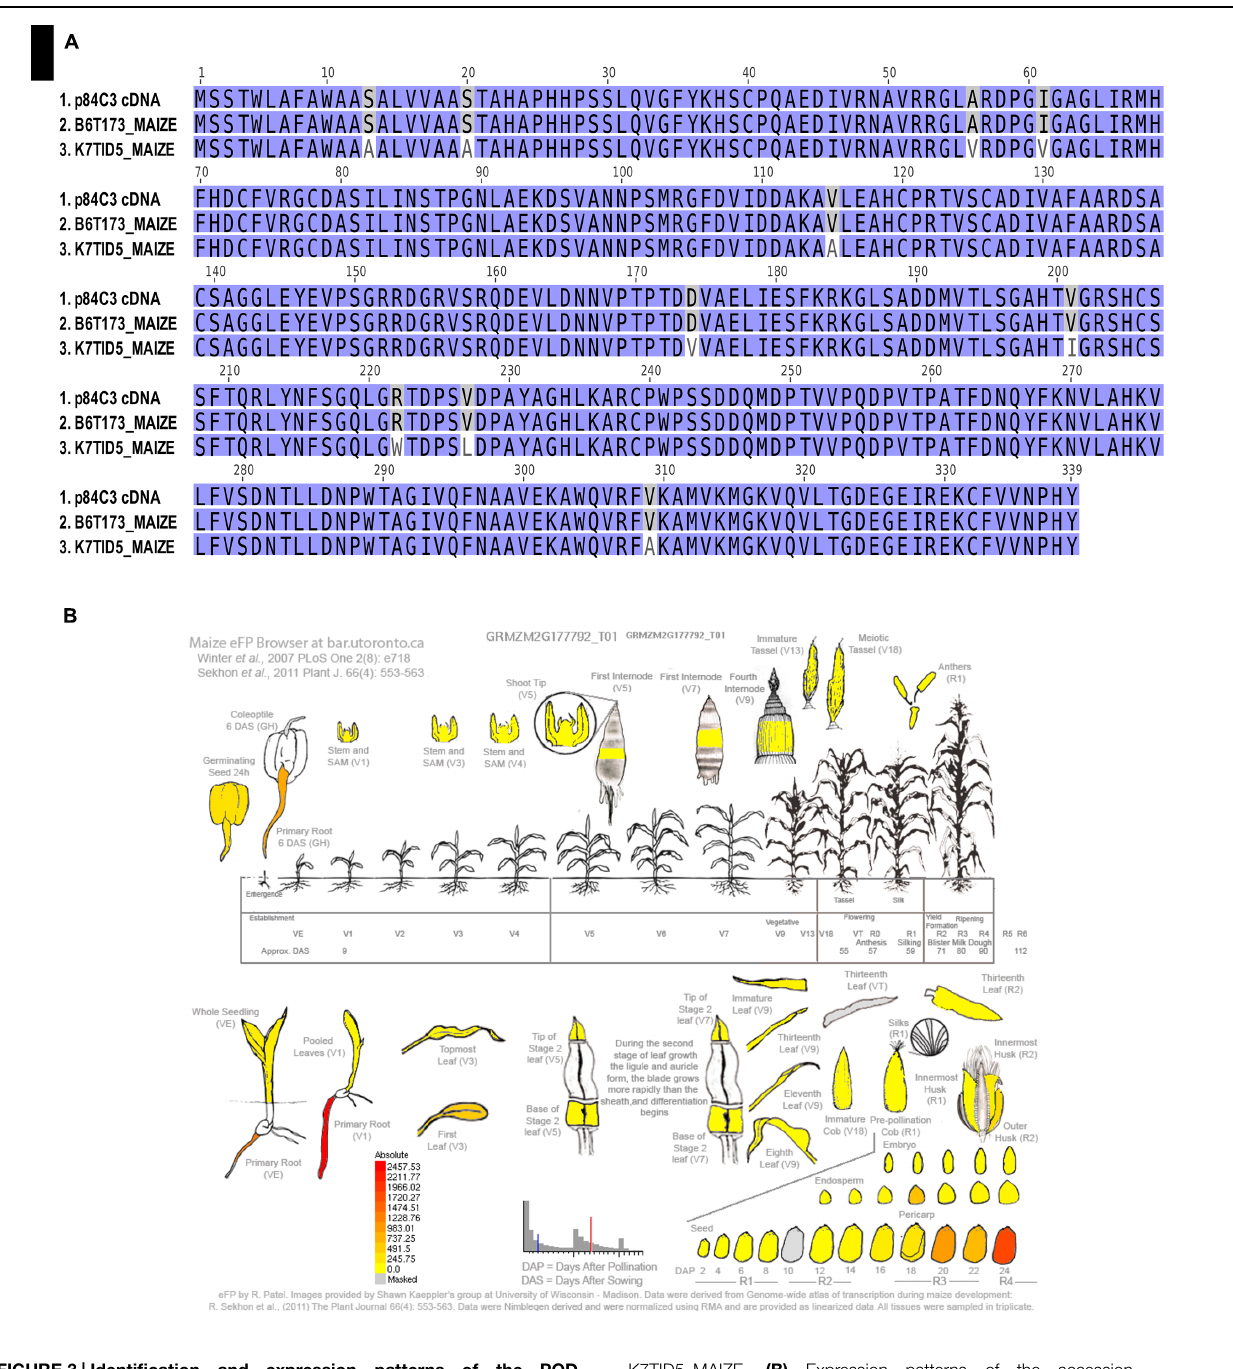
K7TID5_MAIZE. (B) Expression patterns of the accession GRMZM2G177792_T01 accession in B73 maize (corresponding to B6T173_MAIZE UniProt accession) using the Maize eFP Browser (http://www . bar . utoronto . ca/).